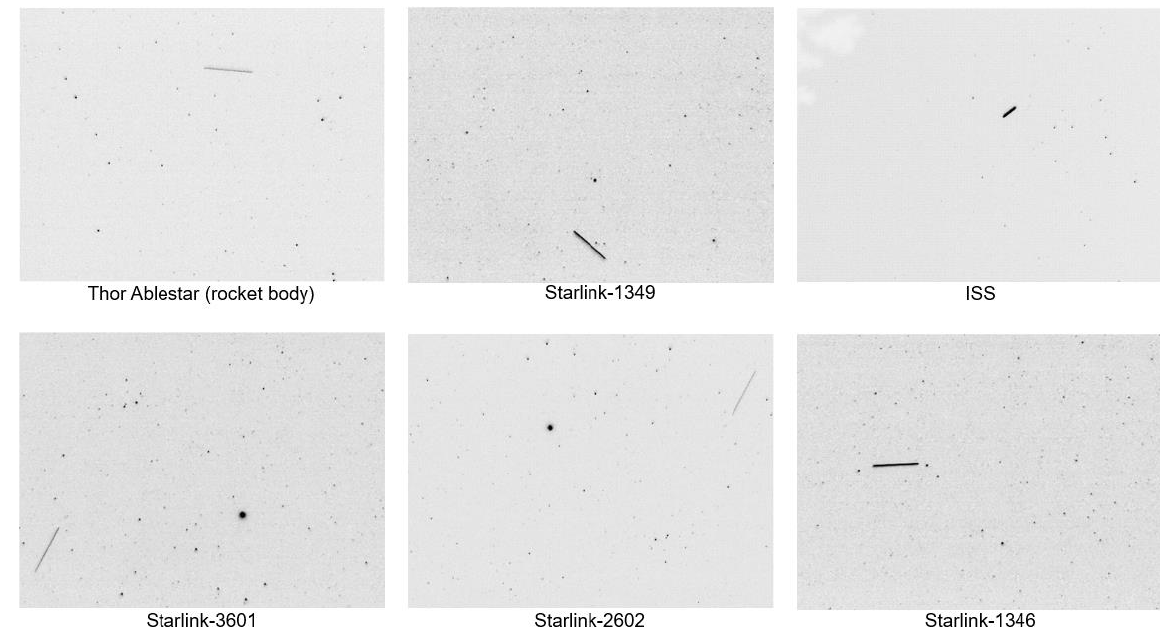
Figure 9. Some detected objects.